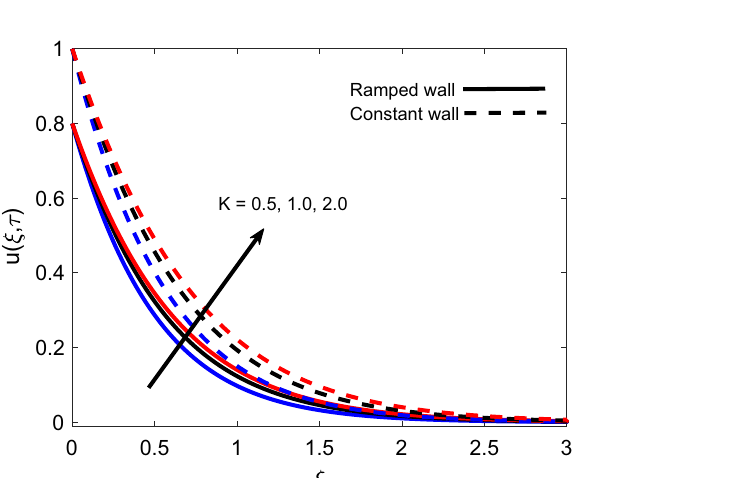
Figure 11. Velocity distribution for various values of K .